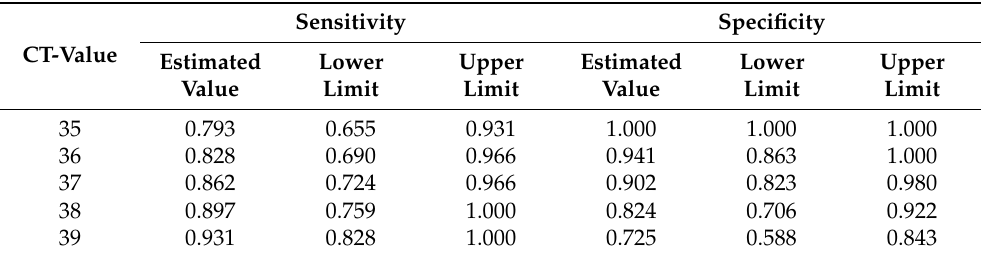
Table 4. Sensitivity and specificity of different CT-values following CT-value limits within the 95% confidence